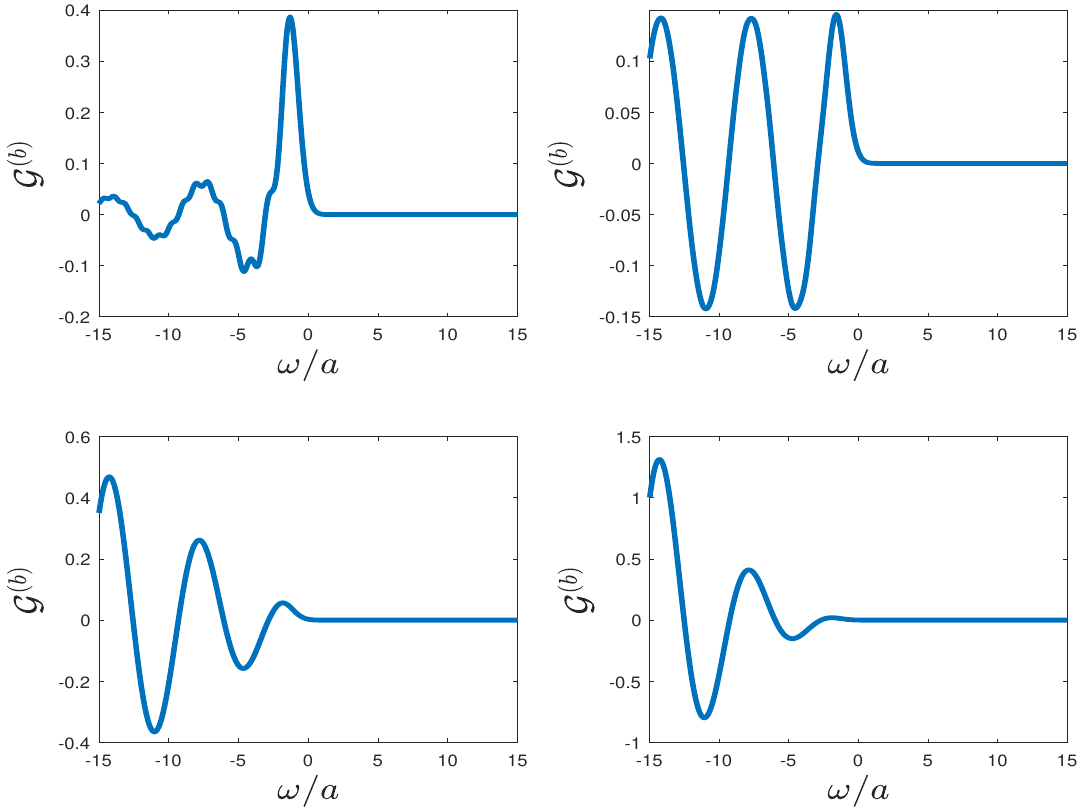
Figure 12 . Behavior of G ( b ) for massive field in different spacetime dimensions. The four subfigures stand for D = 3 , D = 4 , D = 5 , and D = 6 , respectively, from left to right and top to